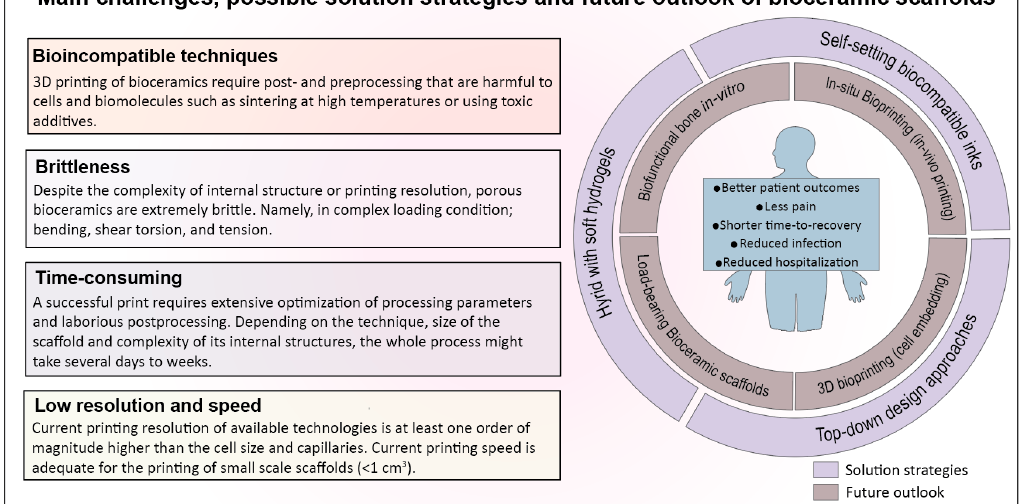
Figure 2. Schematic of the main challenges in additive manufacturing of bioceramic scaffolds, proposed solution strategies, and future outlook where the new research might overcome those challenges.